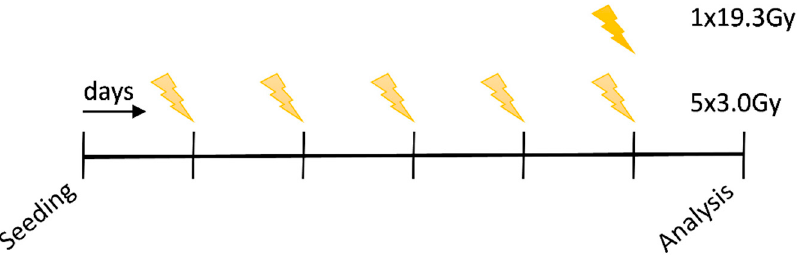
Figure 5. Irradiation schedule of the HNSCC cell lines with 5x3.0Gy (hypofractionated) and 1x19.3Gy (high single dose). Seeding of the cells was carried out on day 1, irradiation with 5x3.0Gy on day 2–6 and 1x19.9Gy on day 6, respectively. On day 7, analysis of the cells via flow cytometry or collection of cell pellets in TriFast was performed. In the above scheme, each vertical line represents one day of the experiment.